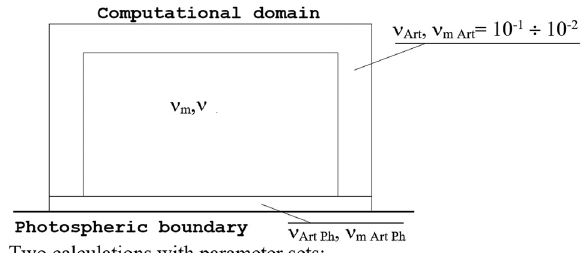
Figure 1: Viscosity and arti fi cial viscosity for two calculation